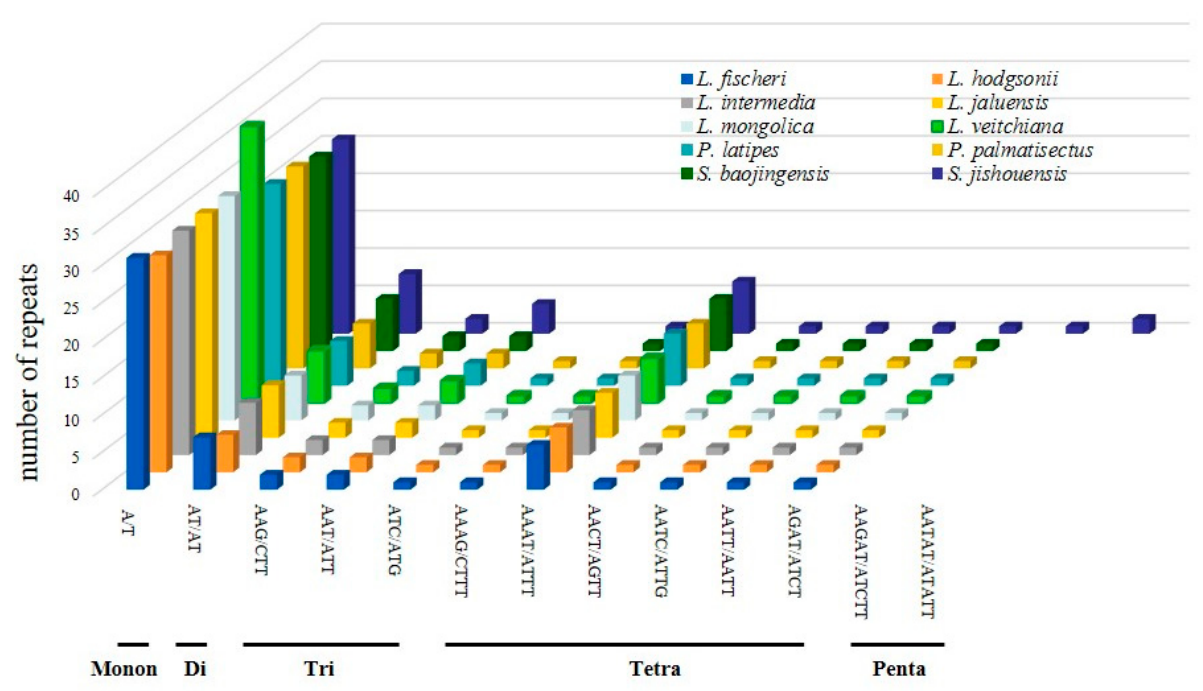
Figure 3. Number of identified SSR motifs in different repeat class types of 10 Senecioneae species of cp genomes.